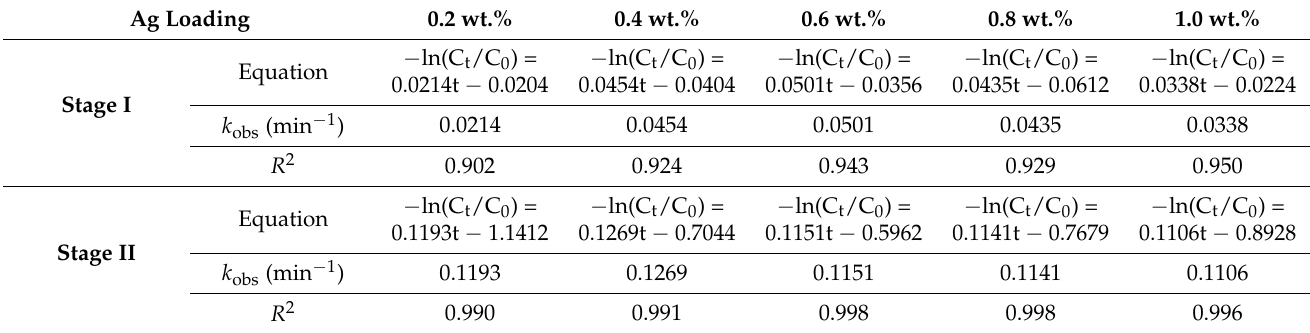
Figure 4. Reaction kinetics for CCl 4 degradation by Ag/Fe particles. Reaction conditions: Ag/Fe dosage of 20 g/L, initial CCl 4 concentration of 20 mg/L, initial solution pH of 7, and stirring rate of 200 rpm. Table 2. Rate constants for CCl 4 degradation by 20 g/L Ag/Fe particles with different Ag loadings. Ag